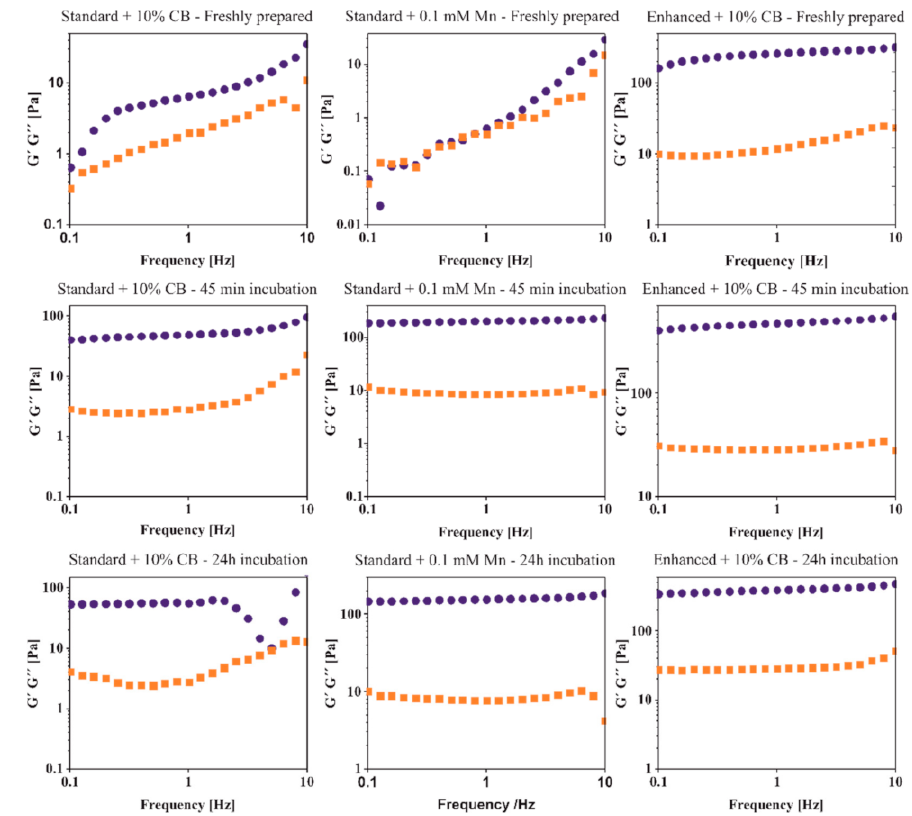
Figure 1. Rheological analysis of the different alginate hydrogels, with/without manganese addition, and different calcium alginate particle concentrations. The analysis was performed immediately after hydrogel formation (upper row), following 45-min incubation with aCSF (middle row) and after 24-h incubation with aCSF (bottom row)—data presented as mean, n = 3; orange squares—G” shear modulus (viscous component) (Pa), blue dots—G’ shear modulus (elastic component)